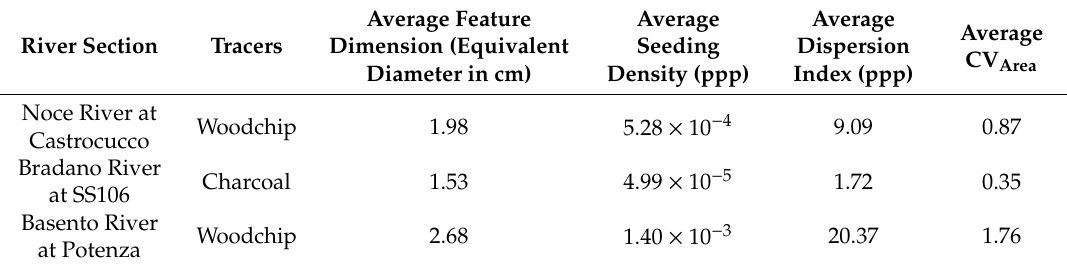
Figure 5. Comprehensive overview of seeding behaviour during considered acquisition time for each study case. ( A ) Seeding density in particles per pixel (ppp), ( B ) mean area of tracers in cm 2 , ( C ) dimensionless dispersion index, and ( D ) coefficient of variation of the tracers’ area. Table 3. Average seeding characteristics.